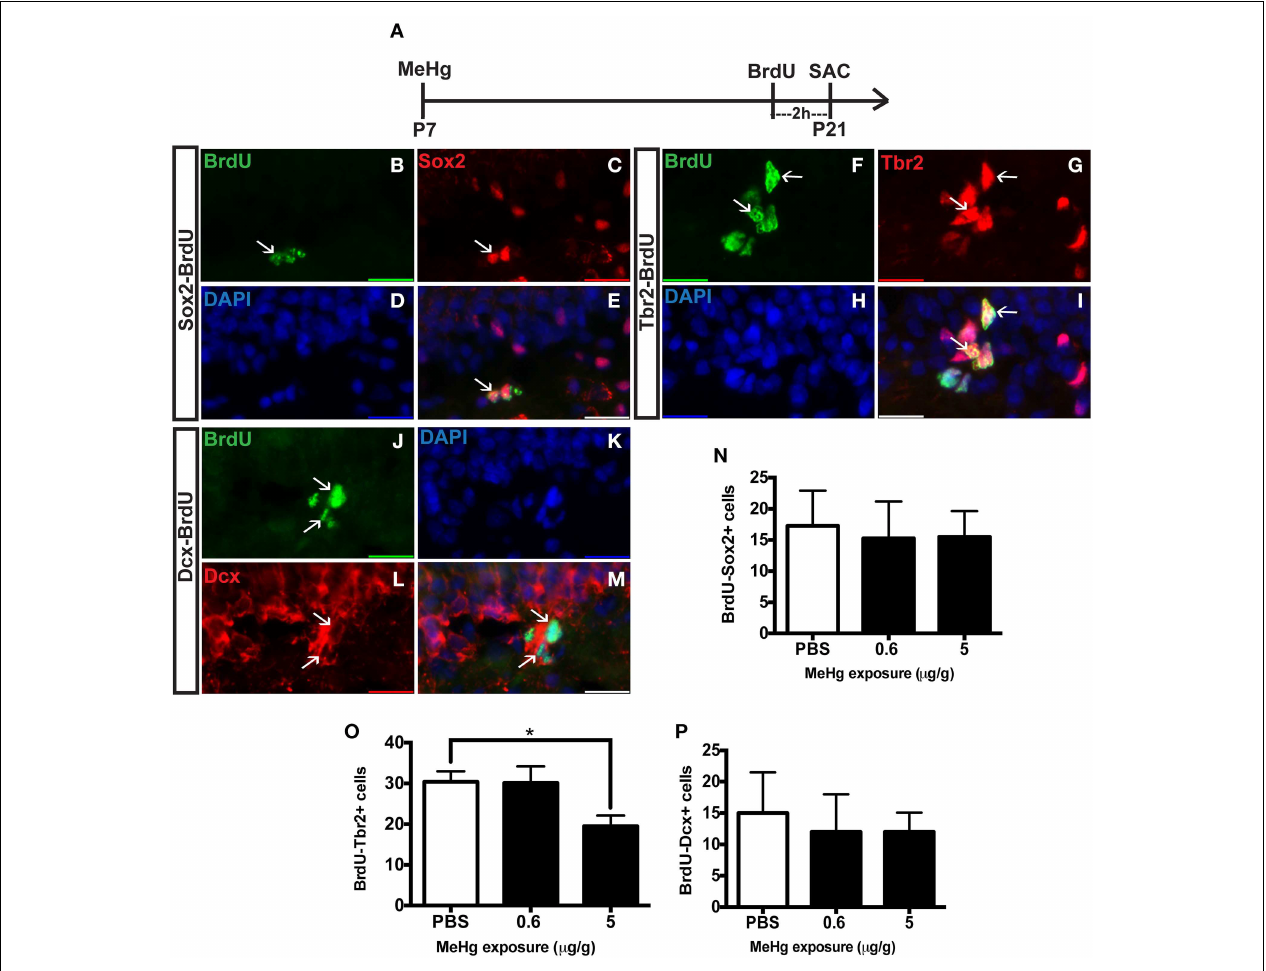
FIGURE 2 | Early (P7) MeHg exposure leads to a deficit in S-phase of intermediate progenitor cells in the adolescent (P21) hippocampus. (A) Experimental timeline. (B–E) BrdU-Sox2 + double staining in the hilus of the dentate gyrus (DG). Arrows indicate double-positive cells. (B) S-phase cells labeled by BrdU (green), (C) NSCs labeled with Sox2 (red), (D) nuclei labeled with DAPI (blue), (E) merged image. (F–I) BrdU-Tbr2 + double staining in the SGZ of the DG. (F) BrdU (green), (G) intermediate progenitor cells labeled by Tbr2 (red), (H) DAPI (blue), (I) merged image. (J–M)